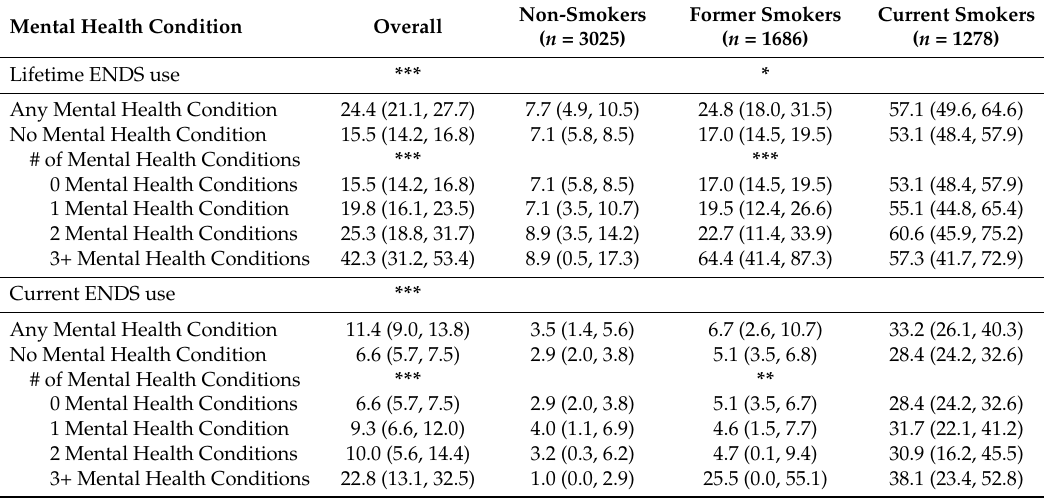
Table 3. Lifetime and current use of Electronic Nicotine Delivery Systems (ENDS) by lifetime mental health condition and smoking status.